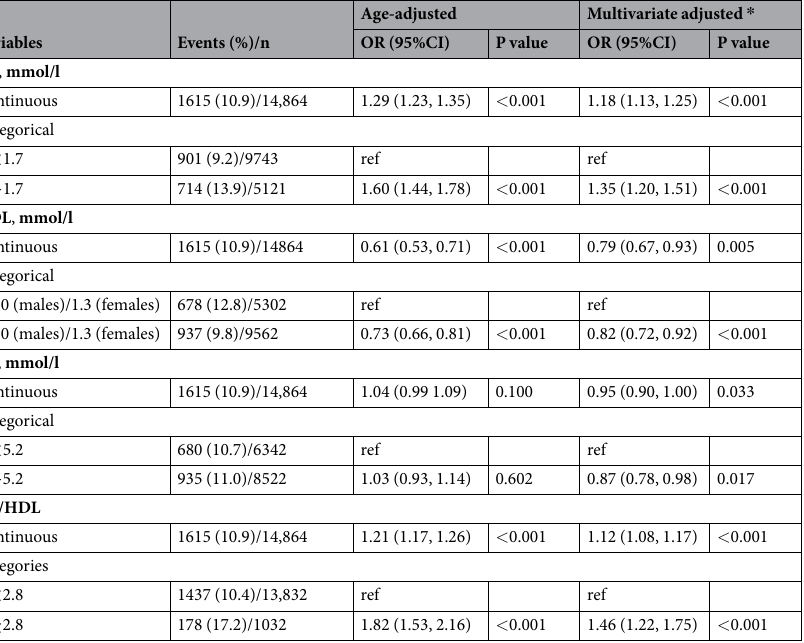
Table 2. Odds ratios of lipid levels for NOD by logistic regression. Abbreviations: TG = triglycerides, HDL = high-density lipoprotein, TC = total cholesterol, NOD = new-onset diabetes. * Adjusted for age, gender, clinical center, SBP, DBP, smoking and drinking status, baseline FPG, and